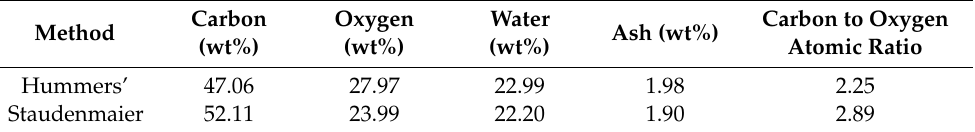
Table 2. Comparison of graphite oxide produced by Staudenmaier and Hummers’ method in terms of compositions. Data adapted from